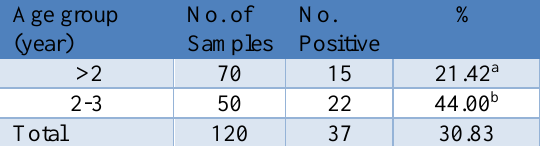
Table, 3: Prevalence of B. sulcata according to the age groups in